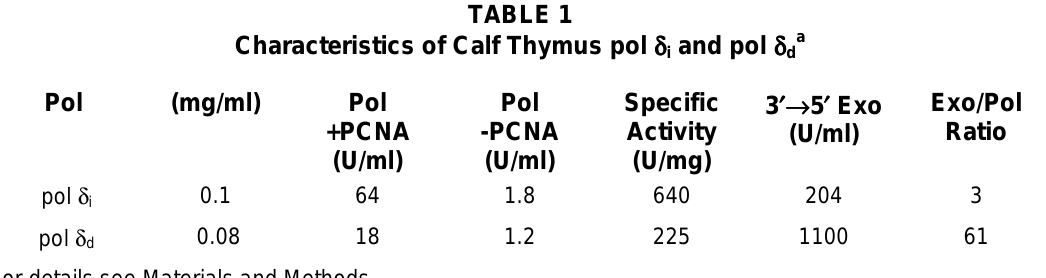
Characteristics of Calf Thymus pol δδδδ